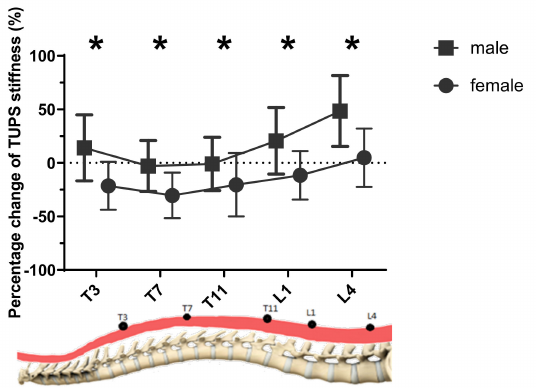
Figure 3. The percentage change of TUPS sti ff ness from lying to standing posture at di ff erent levels of two genders ( n = 64). * Significant di ff erences existed in